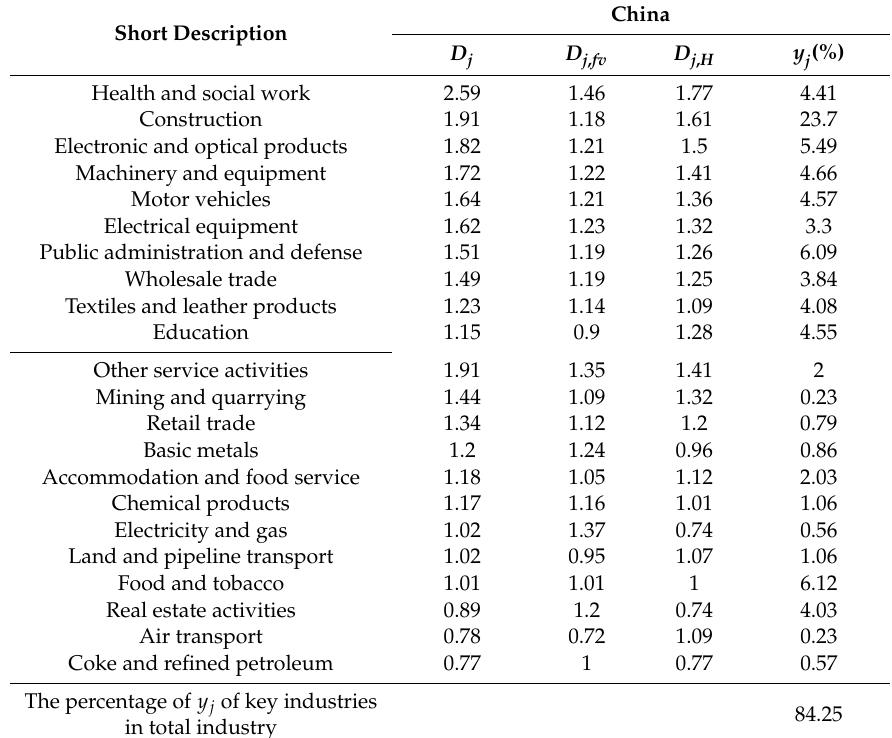
Table 4. Multiplicative SDA of EEI di ff erence of key sectors in China in 2014. Short Description